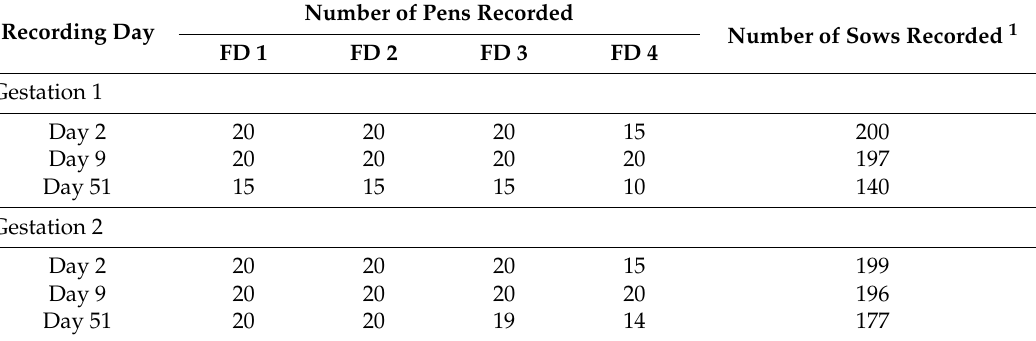
Table 1. Number of pens recorded per feed drop (FD) and day, and total sows recorded per day, in gestations 1 and 2.